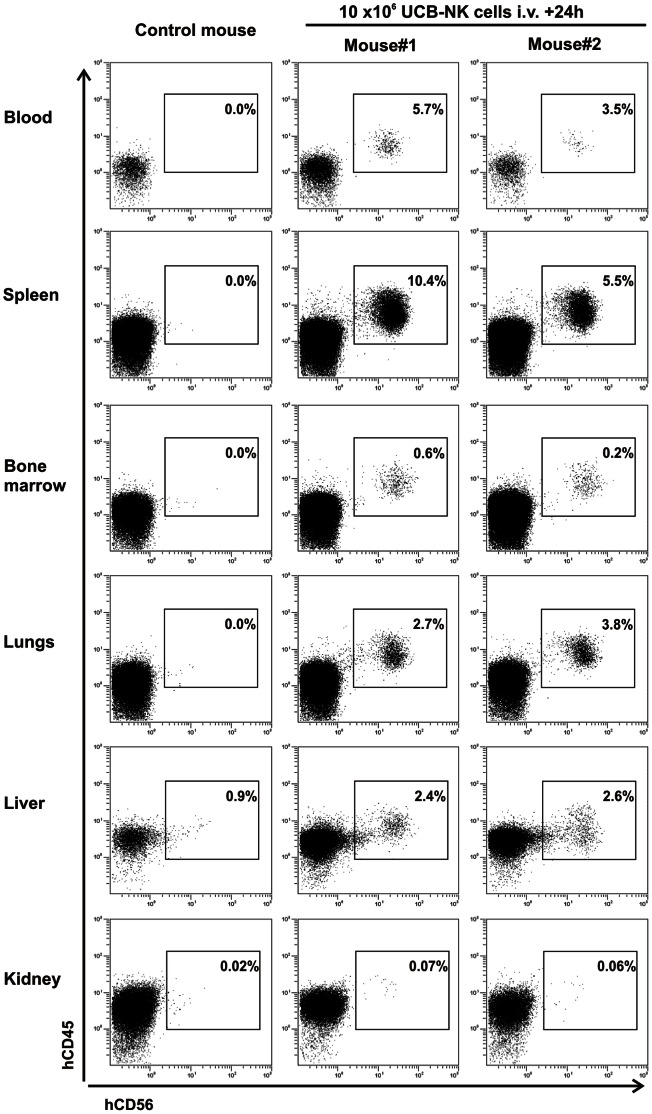

Ex vivo flow cytometric analysis confirmed trafficking of UCB-NK cells through lymphoid tissues, liver and lungs following adoptive transfer in NSG mice.Two adult NSG mice were infused i.v. with 10×106 UCB-NK cells. The day after, mice were sacrificed, organs collected and used to prepare cell suspension for ex vivo flow cytometric analysis following erythrocyte lysis. One additional non-injected mouse was used as control. Presence of human CD45+CD56+ NK cells was confirmed in all examined tissues except kidneys. Dot plots gated on total living cells are shown.